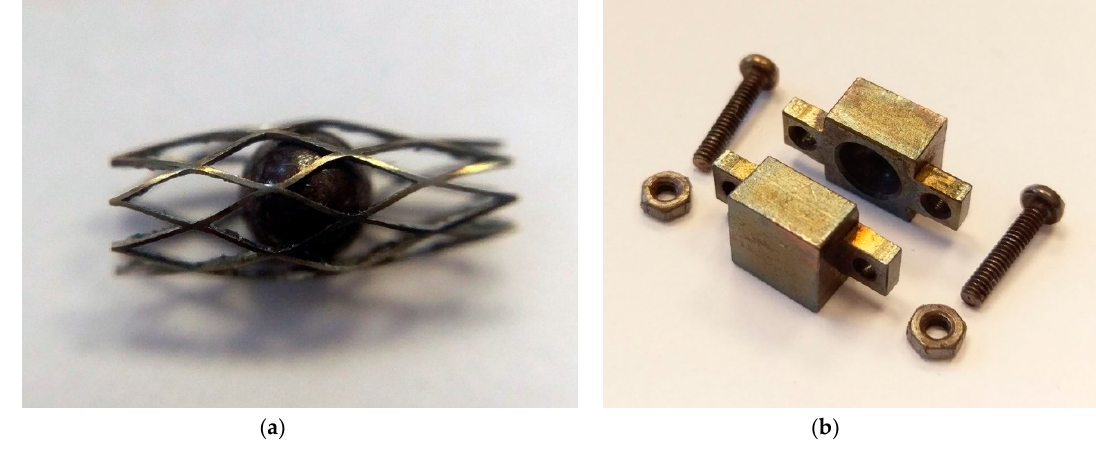
Figure 5. ( a ) Steel ball expanding the spherical occlusion device; ( b ) Special fixture for shaping the device into a perfect sphere from the outside.